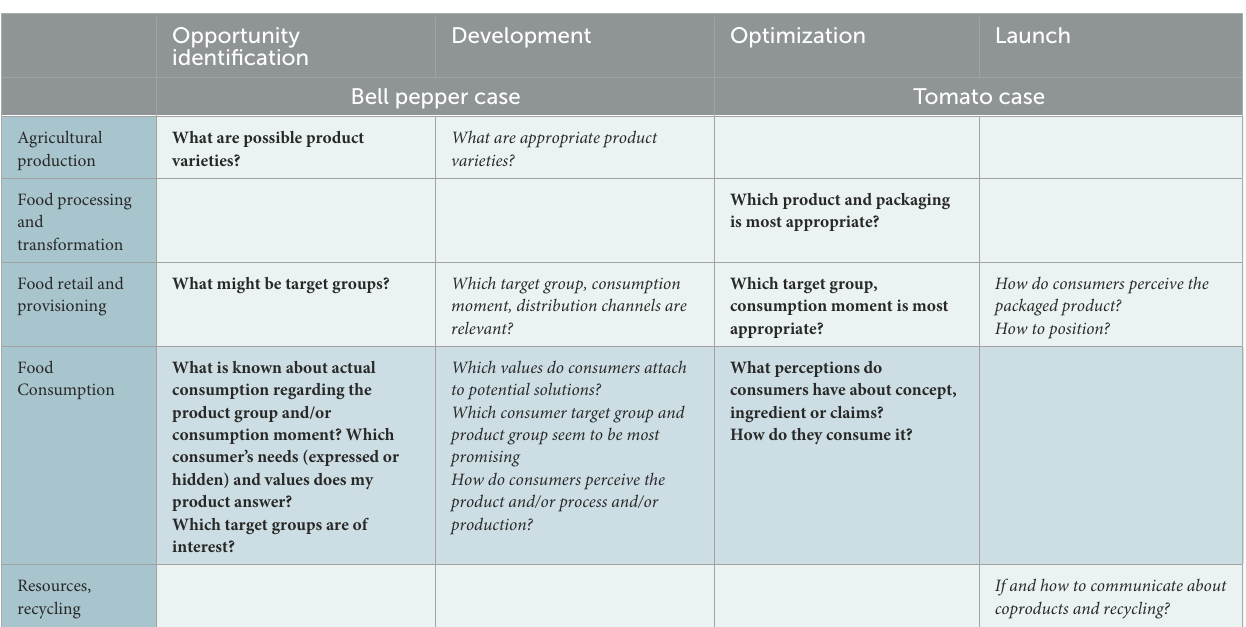
TABLE 1 Questions raised in product innovation cases by the product development phase and food system